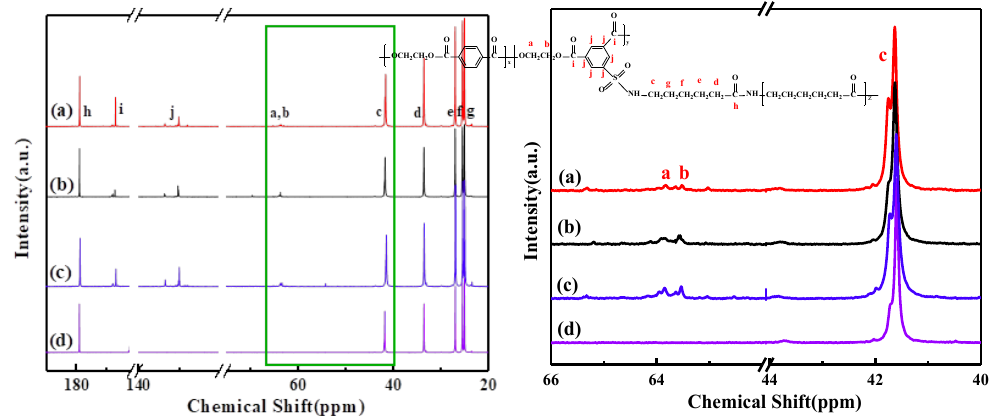
Figure 5. 13 C NMR diagram of the amount of graft copolymers formed in the range of 66–40 ppm: ( a ) LC2/LA(70/30); ( b ) LC4/LA(70/30); ( c ) LC8/LA(70/30); ( d ) PET/LA(70/30).